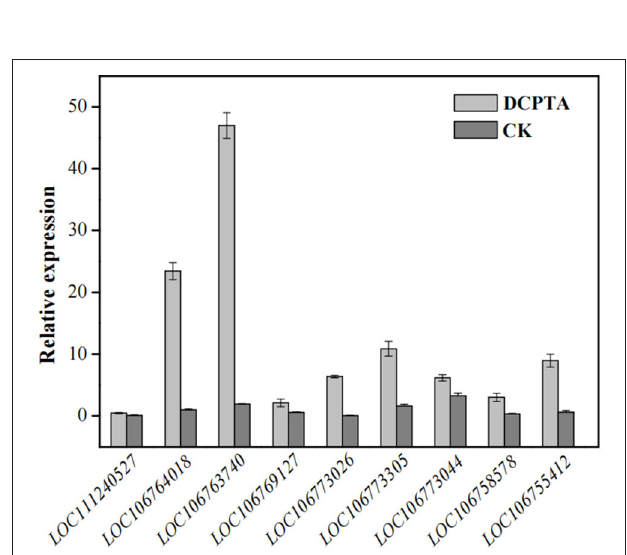
FIGURE 5 | The expression of the DEGs enriched in sucrose synthase, fructokinase, and beta-fructofuranosidase paths. LOC111240527, LOC106764018, and LOC106763740 of DEGs enriched in beta-fructofuranosidase; LOC106769127, LOC106773026, LOC106773305, LOC106773044, and LOC106758578 enriched in sucrose synthase, LOC106755412 enriched in